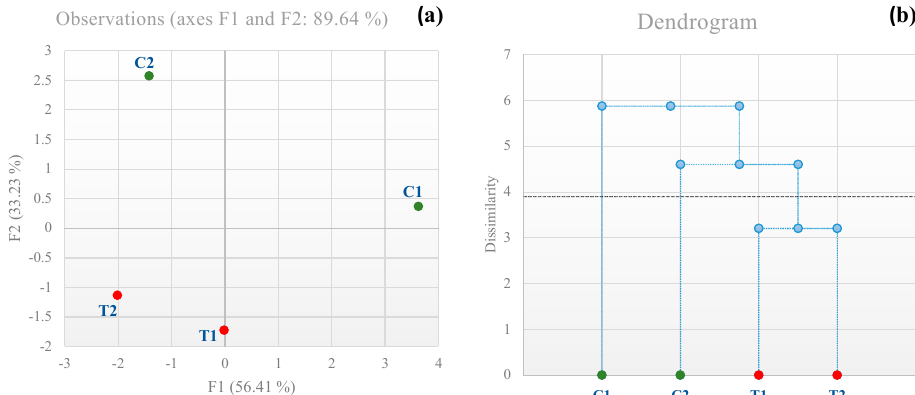
Figure 3. Variable loading plot of MFA.